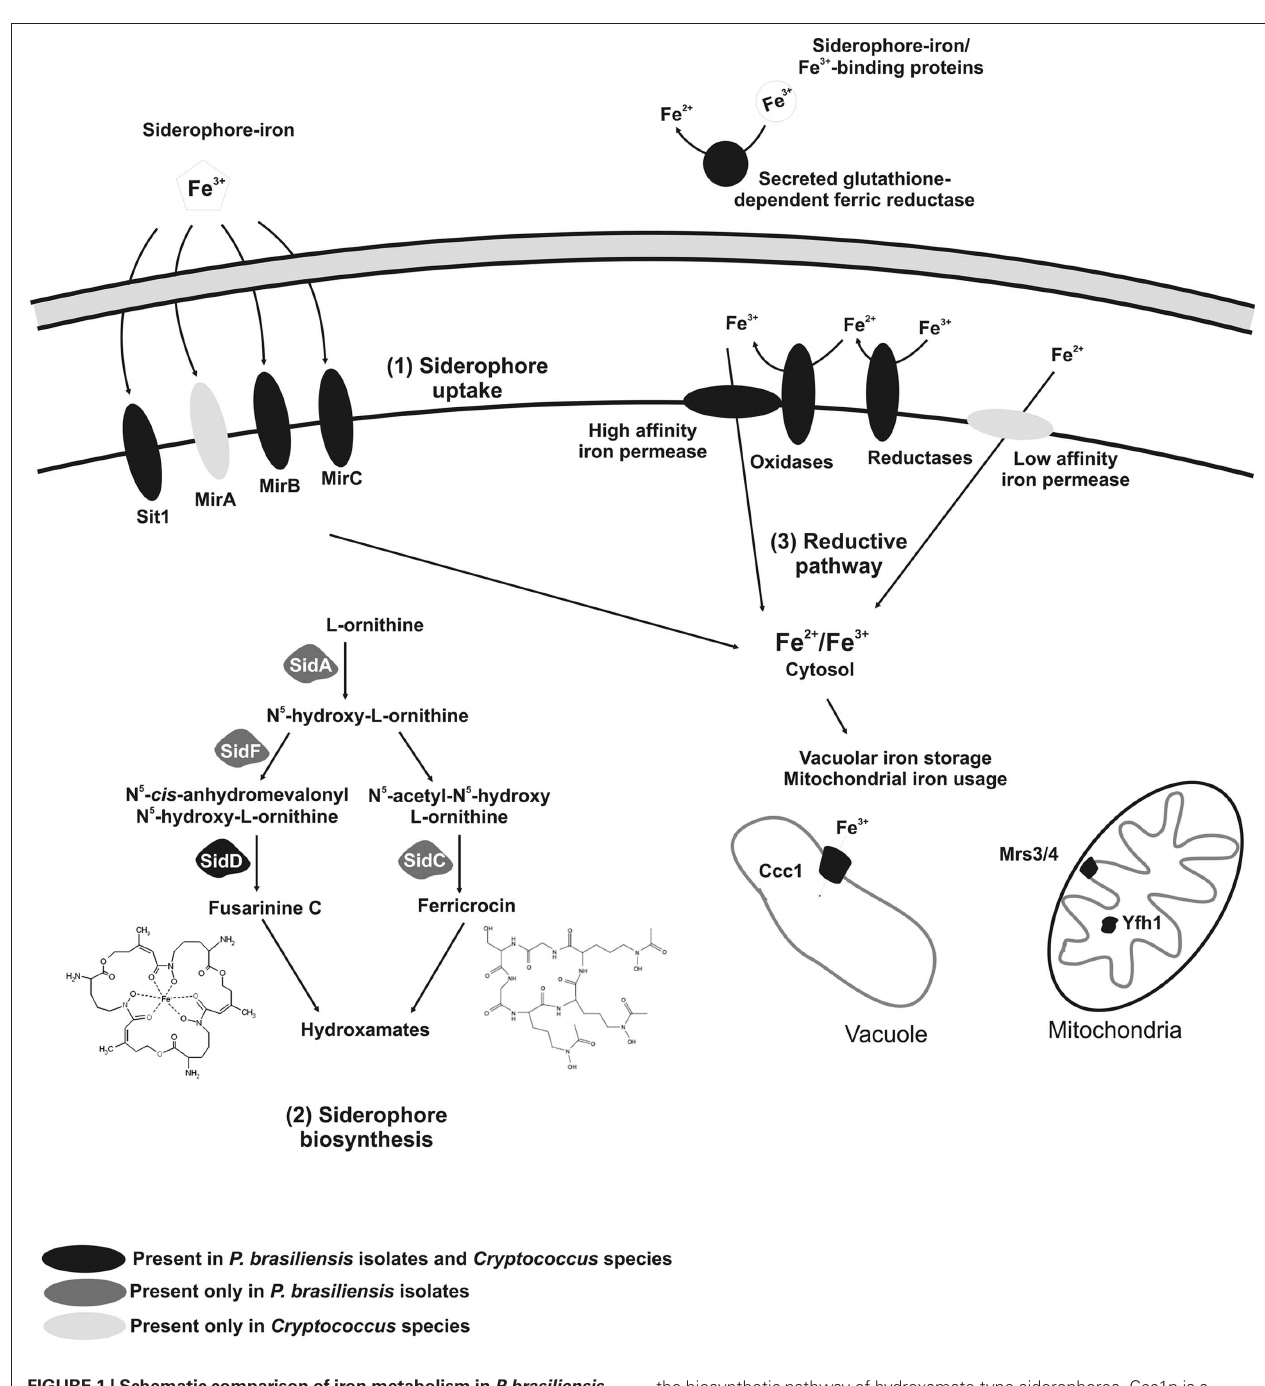
the biosynthetic pathway of hydroxamate-type siderophores. Ccc1p is a vacuolar membrane iron transporter. Mrs3/4p are iron transporters found in the inner mitochondrial membrane and Yfh1p is a mitochondrial matrix